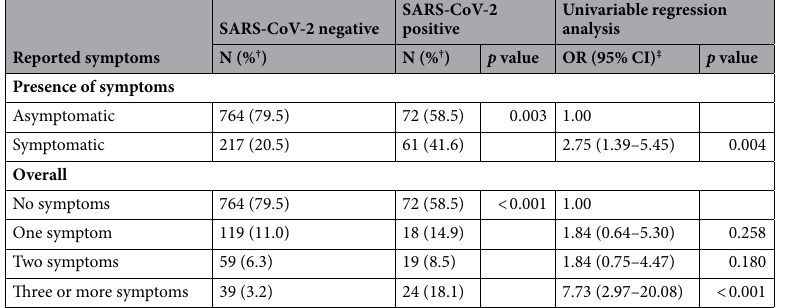
Figure 1 shows antibody prevalence versus the time difference between the first positive PCR test and the antibody test. Overall, antibody positivity was > 88% among those who had their first positive PCR test > 15 days before the antibody test. Antibody positivity declined steadily the closer is the PCR test date to the antibody test date, consistent with a weeks-long delay between onset of infection and development of detectable antibodies. Basic socio‑demographic associations with severe, critical, or fatal infection. Supplementary Tables S5–S7 show basic socio-demographic associations with each of severe and critical infection and COVID- 19 death (all per WHO classification) 3,10 , respectively, as of June 25. After controlling for confounders, age was, by far, the strongest predictor of each of these outcomes, and more so for critical infection and death (Fig. 2). Risk of serious disease and death increased immensely for those > 50 years of age, who are a small minority in the population of Qatar (8.8%).